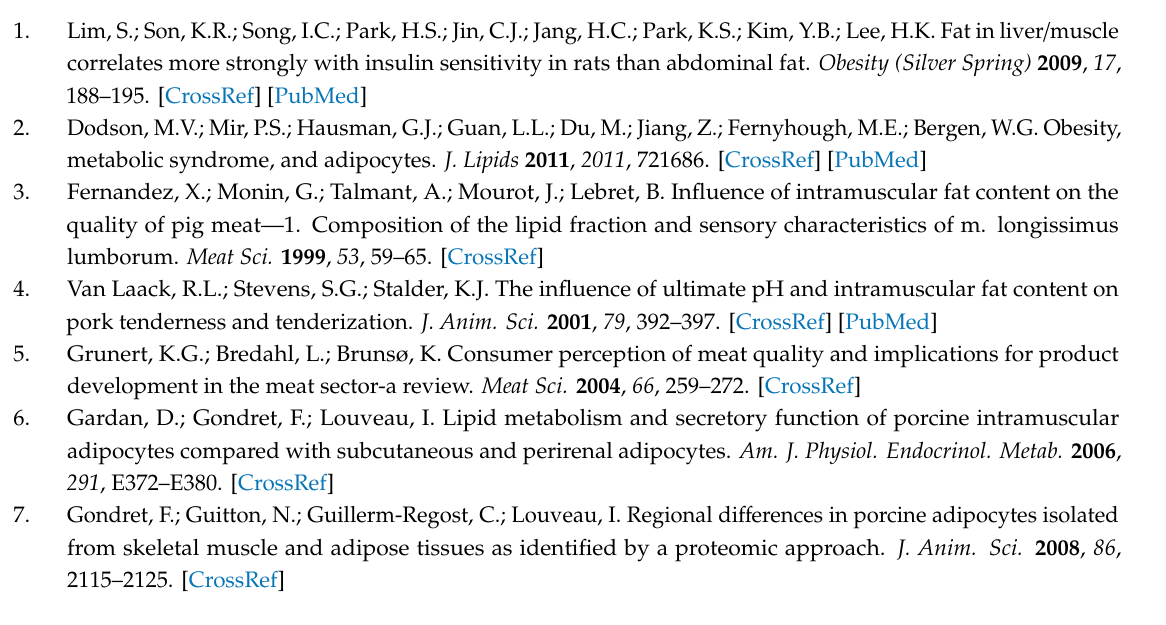
Figure S1: LKB1 overexpression alters the transcriptional profile of SCF adipocytes; Figure S2: LKB1 overexpression alters the transcriptional profile of IMF adipocytes; Figure S3: Expression levels of adipogenesis-related genes in mouse IMF and iWAT adipocytes during adipogenic di ff erentiation; Table S1: Primers used for